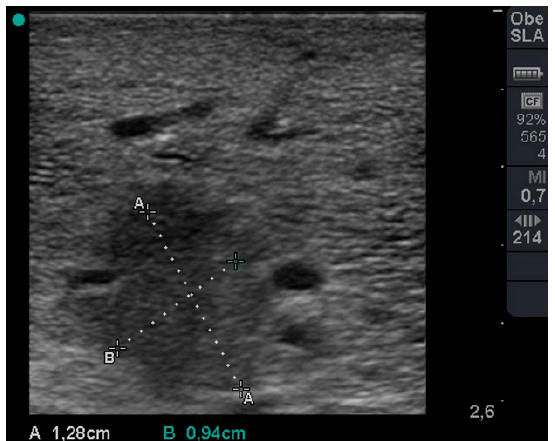
Figure 5. Doppler imaging of central through flooded lung. Pulmonary artery show typical flow characteristics and adjacent bronchus with absence of Doppler signal.